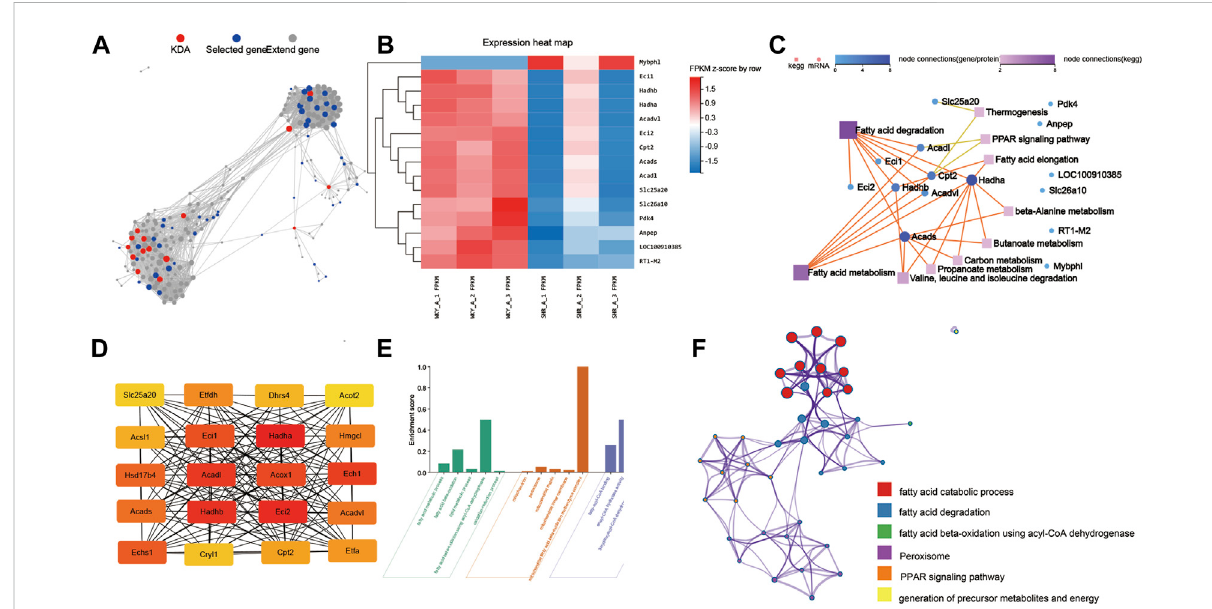
FIGURE 5 NetworkanalysisofDEGsandenrichedpathwaysbetweenTHEWKYandSHRgroups. (A) KDAanalysisidenti fi ed15keydrivergenesintheDEGs between SHR and WKY rat atria: Key driver genes are shown in red, initial genes are shown in blue, and extended genes are shown in gray. (B) Heatmap of the 15 key driver genes. (C) Network analysis between key driver genes and enriched KEGG pathways: Dots represent genes, squares represent KEGG pathways, and lines between genes and squares indicate that the gene can be enriched into the corresponding pathway. (D) The top 20 hub genes were selected by the cytoHubba app in Cytoscape 3.8.2 software. The node color changed gradually from yellow to red in ascending orderaccordingto thescore ofhubgenes. (E) GO andenrichmentnetwork ofthetop20hubgenesbetweenSHRandWKYratatrium. (F) The enrichment network of top 20 hub genes was identi fi ed in the rat atrium. Nodes represent functions enriched for an annotated ontology term and node size indicates the number of genes that fall into that term. KDA, key driver gene analysis; WKY, Wistar-Kyoto; SHR, spontaneously hypertensiverat;KEGG, kyotoencyclopedia ofgenesand genomes;BP,biologicalprocess; CC,cellular component; MF, molecular function; MAPK, mitogen-activated protein